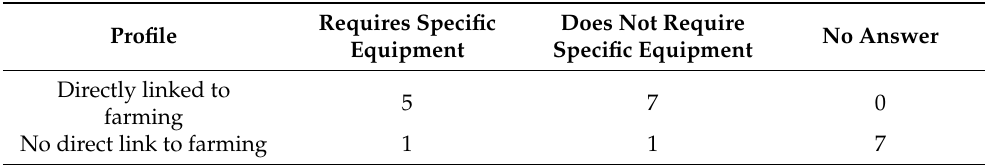
Table 4. Distribution of opinions concerning the specificity of equipment according to